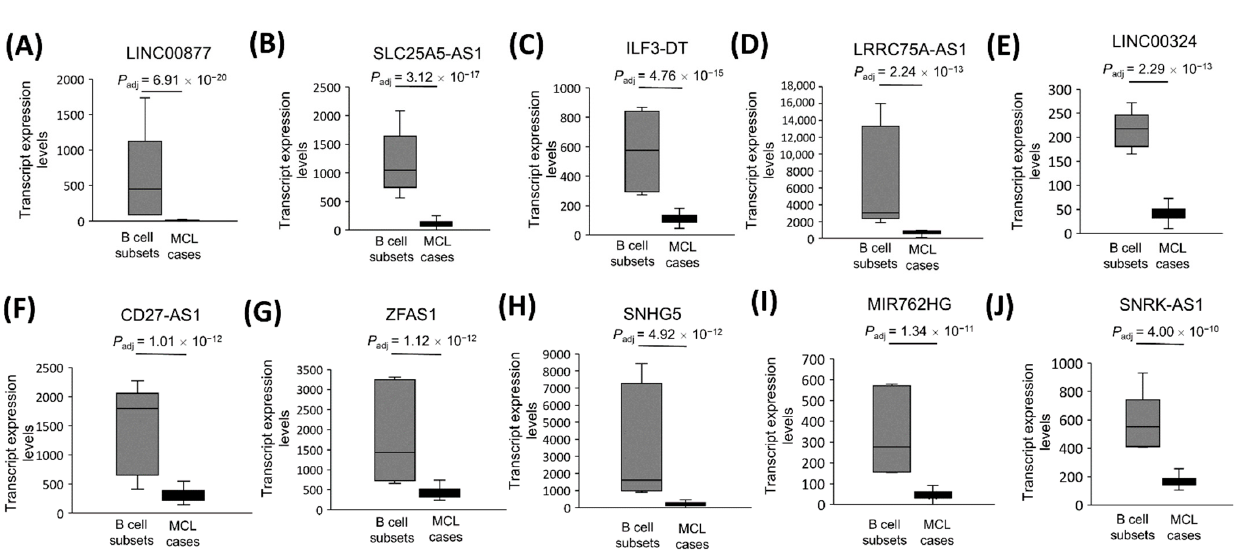
Figure 8. The transcript expression levels of the 10 most significantly downregulated tumor suppressor candidate lncRNA genes in MCL. Tumor suppressor candidate lncRNA expression levels that are most significantly downregulated are shown for 32 MCL samples and 5 reactive tonsil B-cell subset samples as box-and-whisker plots in the order of decreasing statistical significance ( A–J ). Adjusted p values show the statistical significance of expression differences between MCL and the control samples.